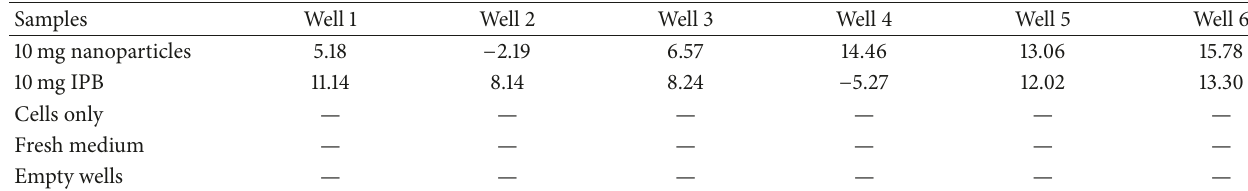
Table 5: Percentage